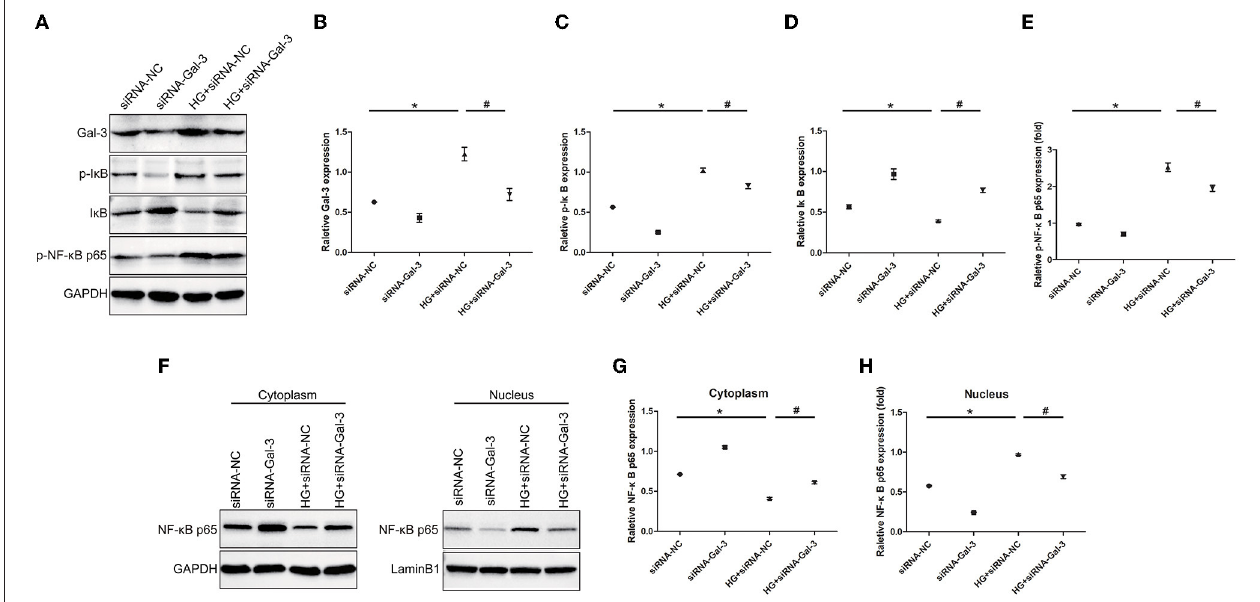
FIGURE 9 | Gal-3 knockdown reduced NF- κ B p65 activation Western bloting analysis of Gal-3, p-I κ B, I κ B and p- NF- κ B p65 (A) . Representative analysis of Gal-3 (B) , p-I κ B (C) , I κ B (D) and p-NF-kB p65 (E) . (F–H) Western blotting analysis of NF- κ B p65 in cytoplasm and nucleus. Representative analysis of NF- κ B p65 in cytoplasm and nucleus. Data are shown as mean ± SD. n = 3, * P < 0.05 vs. siRNA-NC; # P < 0.05 vs. HG +